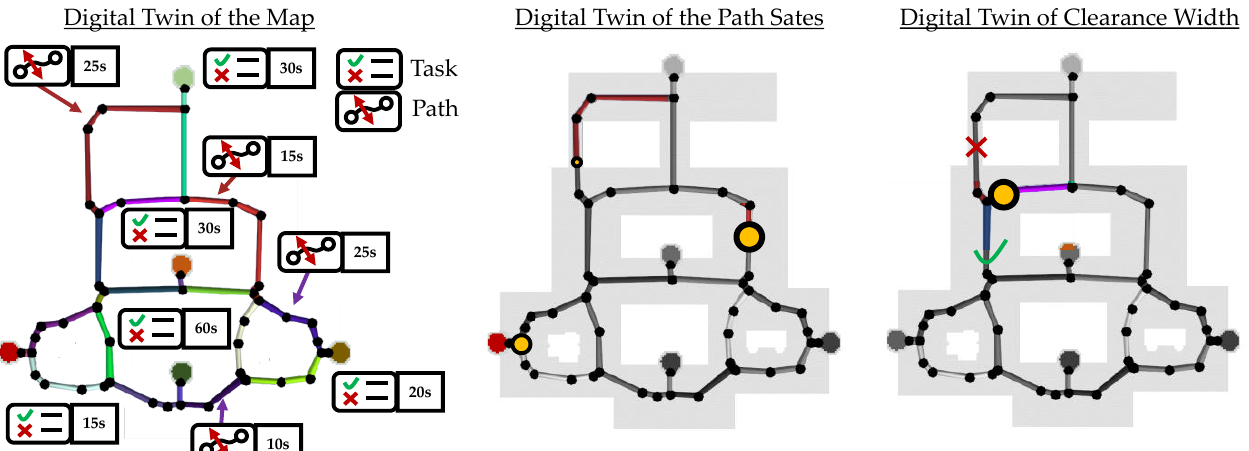
Figure 14. Generation of the digital twin: labeling of edges and nodes over task and process time, a model for traversing paths, a model for passable paths.